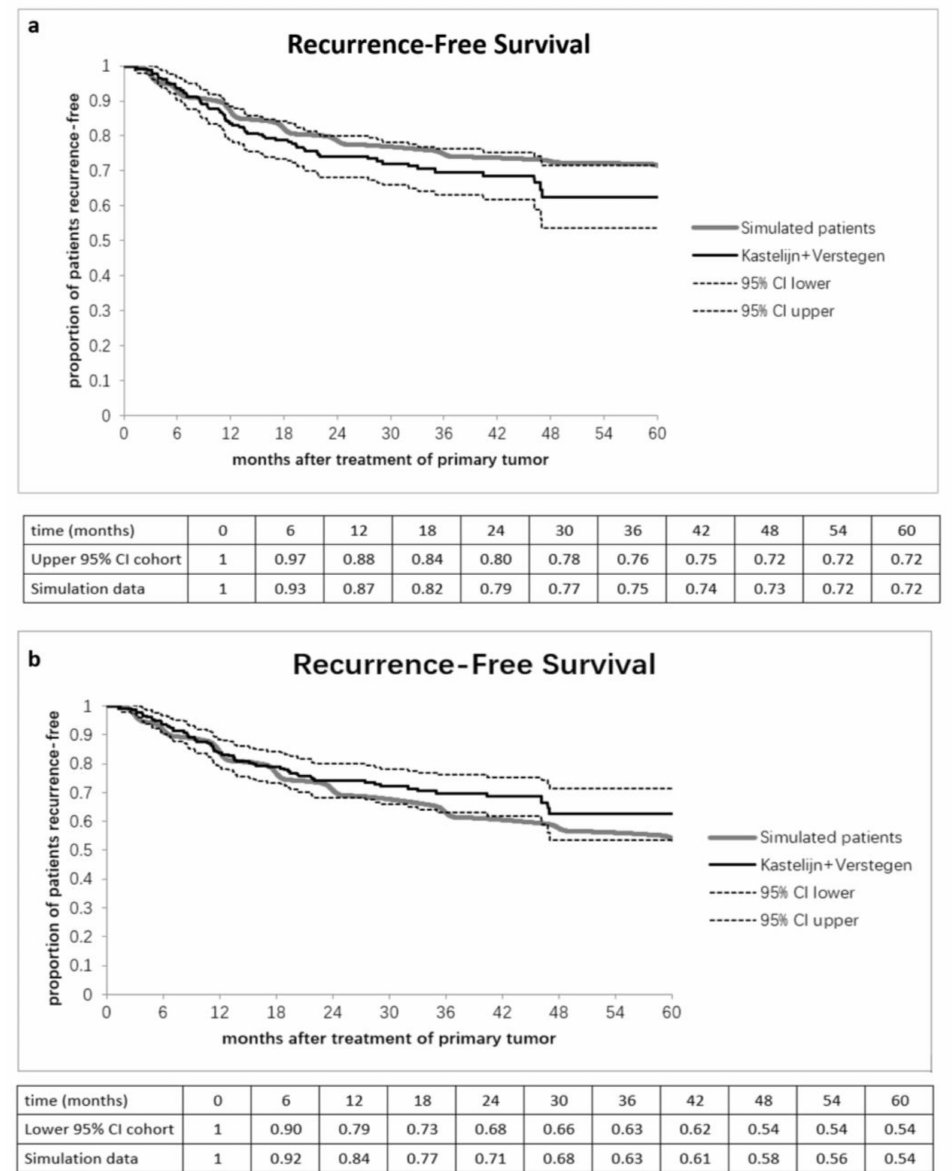
Figure A1. Detection of recurrences in sensitivity analyses. Sensitivity analysis with t detectable calibrated to upper 95% CI of the progression-free survival ( a ) and the lower 95% CI of the progression-free survival ( b